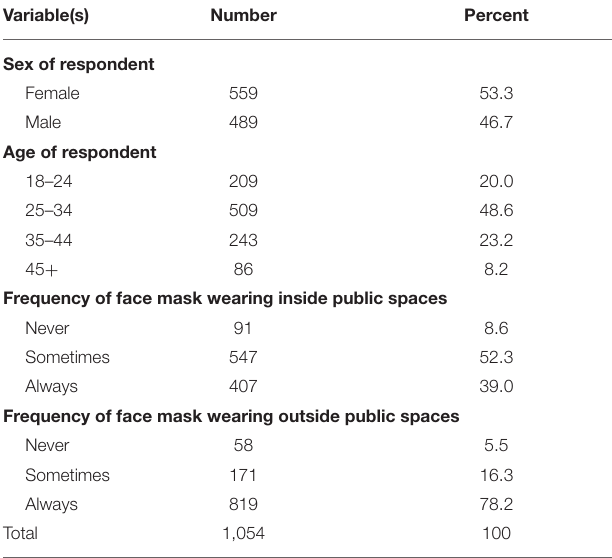
TABLE 1 | Distribution of respondents.